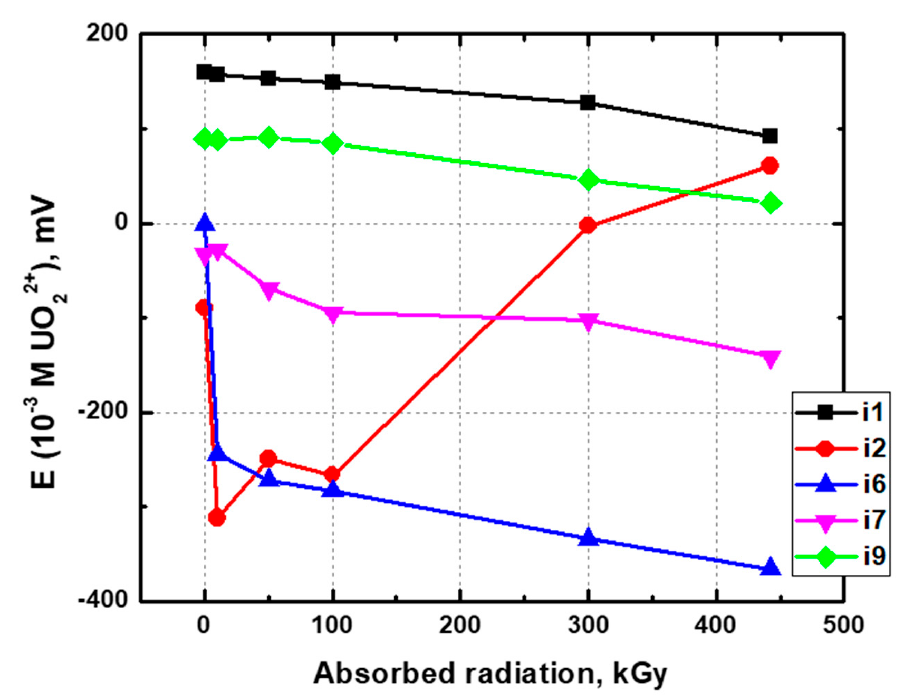
Figure 2. Typical evolution of sensor potentials in 10 –3 M uranyl nitrate solution after the accumulation of the different absorbed radiation doses (the readings of i9 are shifted 60 mV down for better visibility).